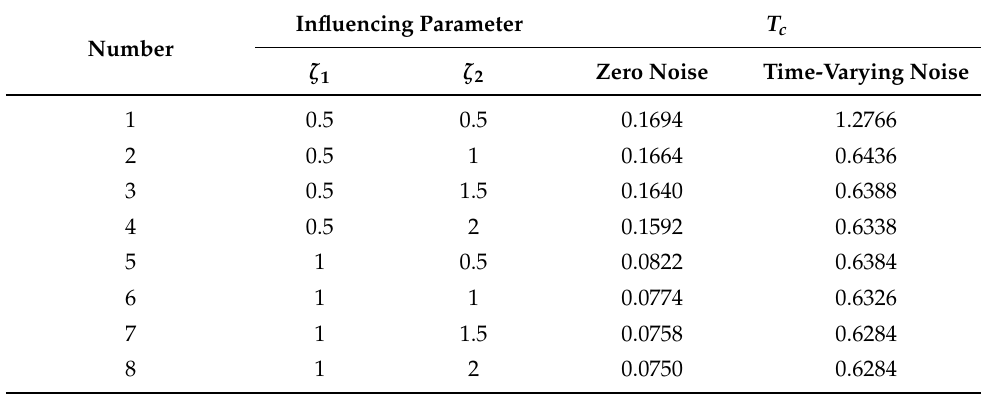
Table 1. The convergence time T c (in seconds) of the DFZNN model under different parameters. Influencing Parameter T Number